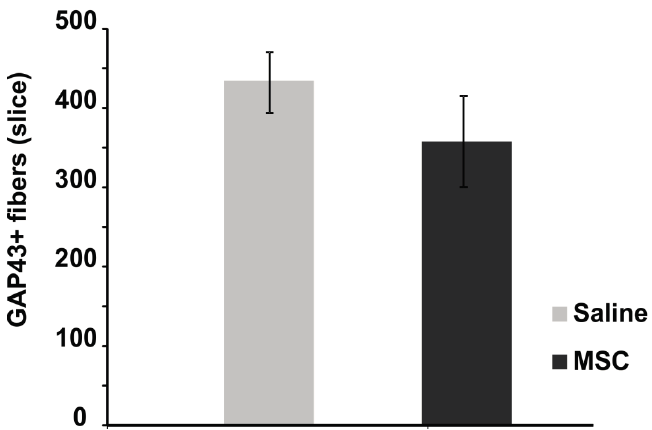
Figure 4. Axonal sprouting after SCI. The graph shows the effect of MSC treatment on axonal sprouting two months after injury. No significant effect of implanted MSCs was observed compared to the control